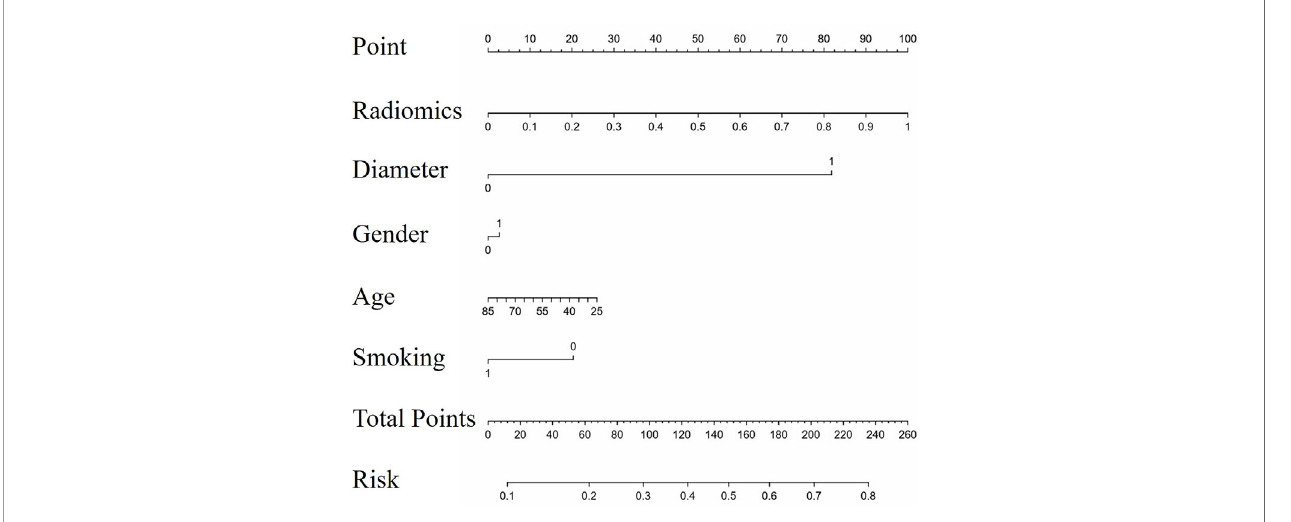
FIGURE 7 | The nomogram to predict progression in original lesions. The nomogram combined radiomic score, max diameter of primary lung lesion, gender, age, and smoking history. In the axis of diameter, 0 represented the max diameter of primary lung lesion ≤ 3.25 cm and 1 represented > 3.25 cm. In the axis of gender, 0 represented male and 1 represented female. In the axis of smoking history, 0 represented non-smokers and 1 represented